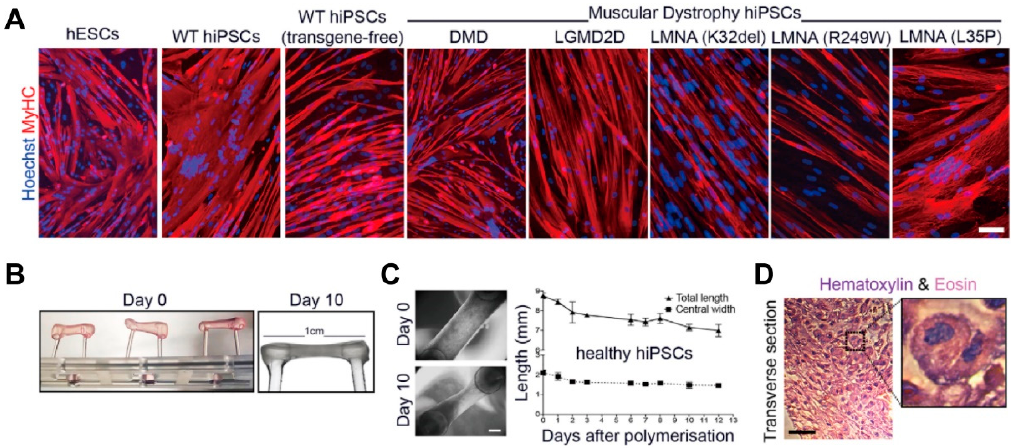
Figure 15. ( A ) Fabrication of a fibrin hydrogels-based engineered heart tissue (EHT) 3D culture system using multiple hPSC line-derived skeletal myotubes and Duchenne muscular dystrophy (DMD) patient-derived skeletal myotubes. Representative images of the EHT (side-view) ( B ), gel remodeling by time, ( C ) and H&E staining. Scale bar: 100 μ m for ( A , D ), 1 mm for ( C ). Reprinted from [108]. Copyright (2018) Elsevier.